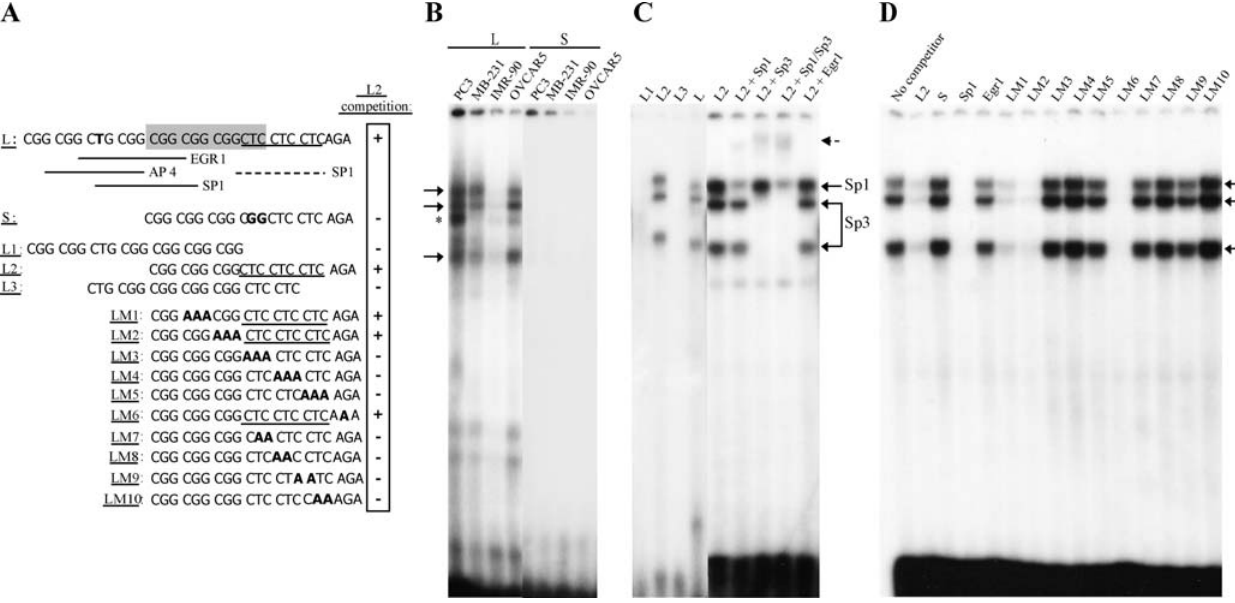
Figure 3. Identification of an Additional Sp1/Sp3 Binding Site in the Long Allele of RIL. (A) Sequences of EMSA probes. L probe sequence is shown on top. The 12-bp region absent in the short allele is shown in a grey box, and T, converted to G in the short allele, is shown in bold. Putative transcription factor binding sites (Transfac/MatInspector prediction) are shown. Mutations are shown in bold (probes LM1-LM10). Bolded nucleotides in the S probe correspond to the nucleotides different with the long probe. The CTCCTCCTC sequence is underlined. The ability of the probes to compete with the L2 probe is indicated on the right ( + or 2 ). (B) Nuclear extracts from various cancer cells were incubated with the 33-bp L or 21-bp S probe. Note the presence of shifts with the L, but not with the S probe, which are indicated by arrows. (C) Nuclear extracts from MDA-MB-231 cells were incubated with three shorter 21-bp versions of the L probe (L1-L3). Notice binding only with the L2 probe, which has an intact 3CTC region. To identify the nature of proteins bound, supershift assays (arrows) of the L2 probe with specific antibodies for Sp1, Sp3, and Egr-1 were performed